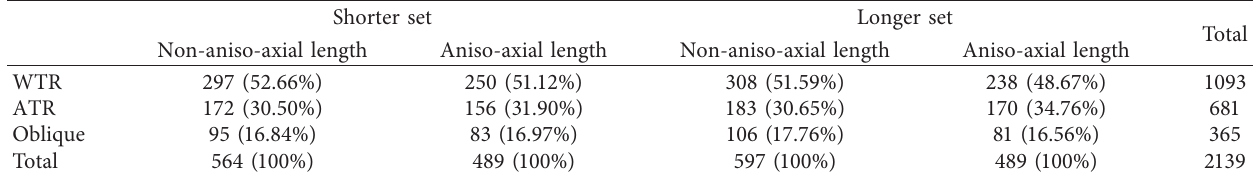
Figure 2: Comparison of astigmatism among the aniso-axial length groups and the non-aniso-axial length groups in the shorter set or the longer set. Non-aniso � non-aniso-axial length group, Aniso � aniso-axial length group. P values were reported by post hoc LSD correction. Table 3: Distributions of total corneal astigmatism divisions in the non-aniso-axial length group and the aniso-axial length group of the two sets.